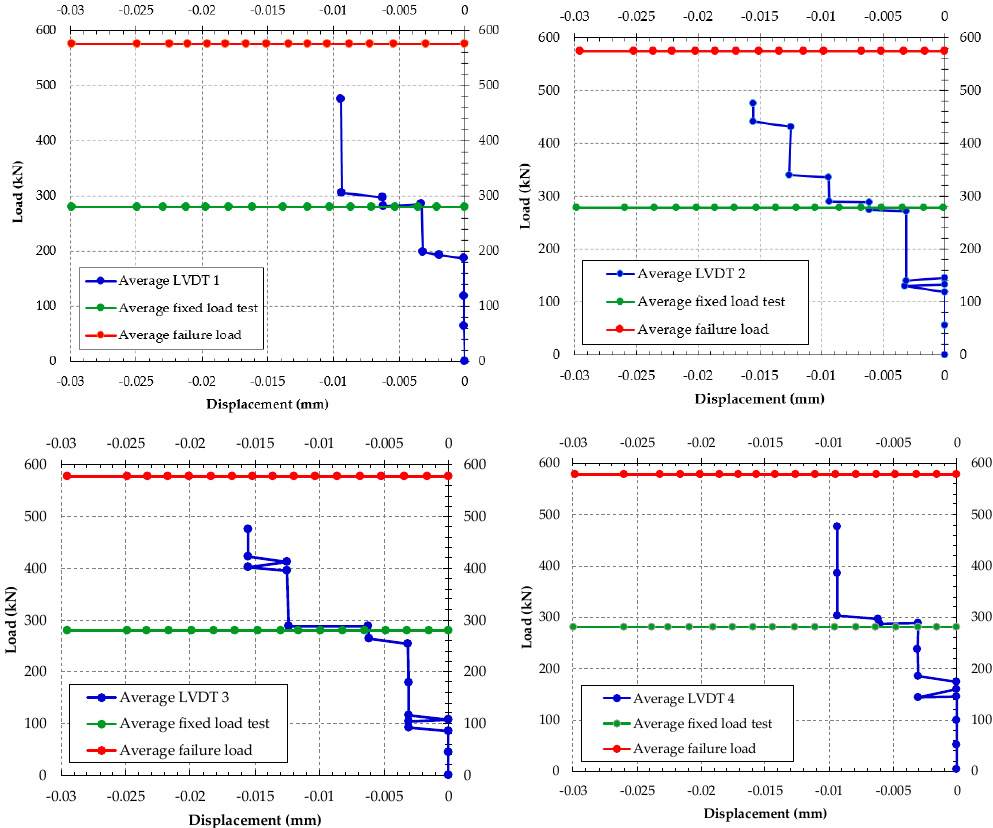
Figure 5. Average failure load of the sleepers tested with load on the support. Table 2. Summary of positive moment at the support.